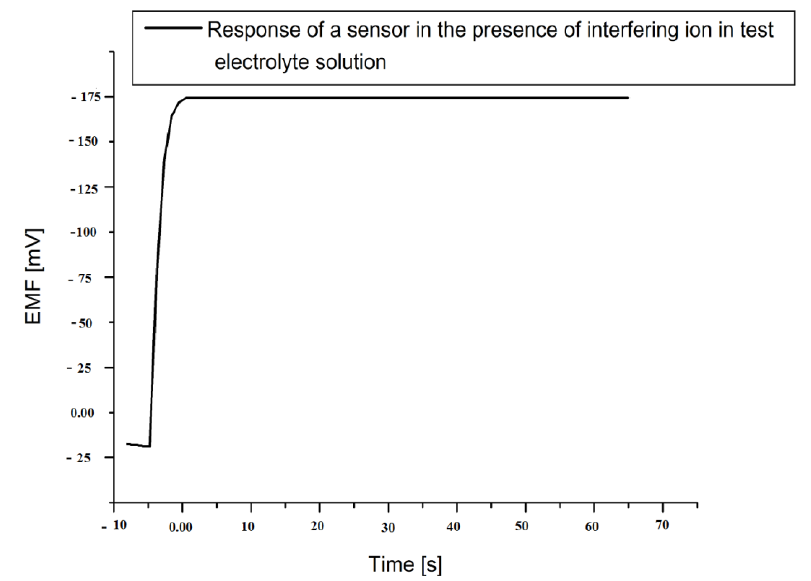
Figure 6. The time response curve of the proposed sensor in a 1,000 µM penicillin electrolytic test solution in presence of interfering species.